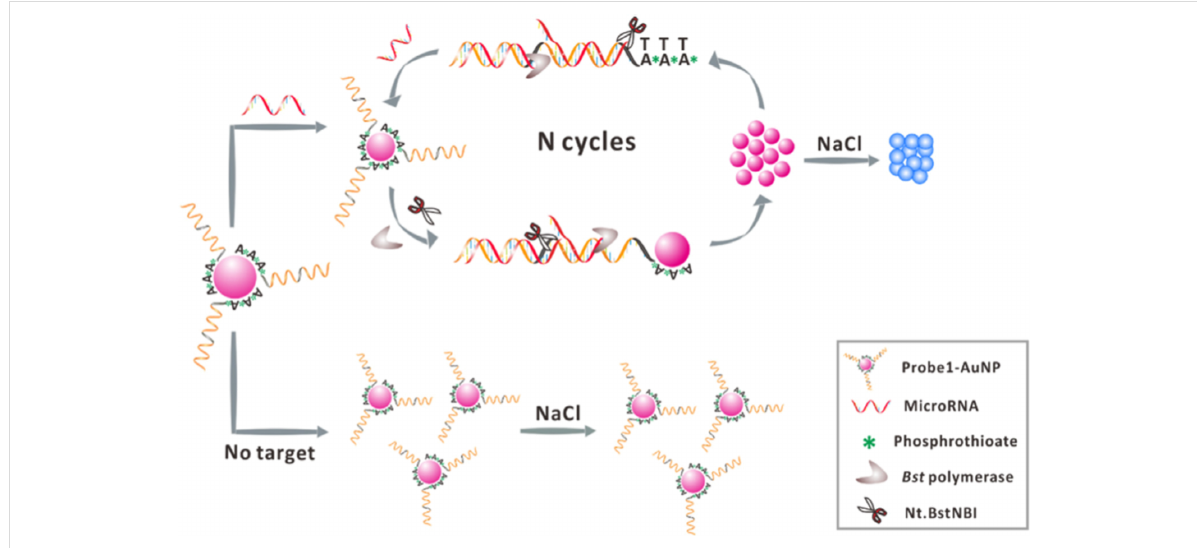
Figure 9: Colorimetric method for the detection of specific miRNA based on the combination of enzyme-assisted exponential amplification and AuNP- based colorimetric detection. The sensing probe attached to the gold nanoparticles can be easily disrupted by the enzymes, ensuring thus an im- proved performance. Reprinted with permission from [107], copyright 2016